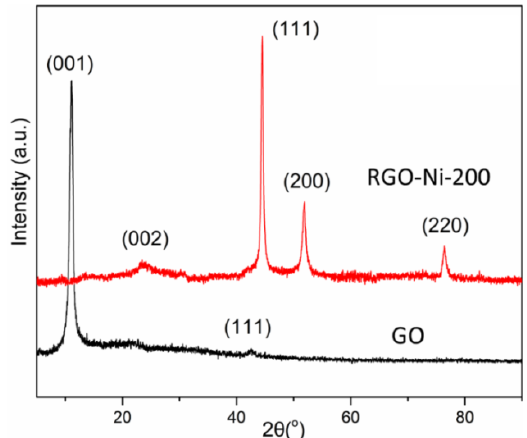
Figure 2. X-ray diffraction (XRD) patterns of GO and RGO–Ni-200.